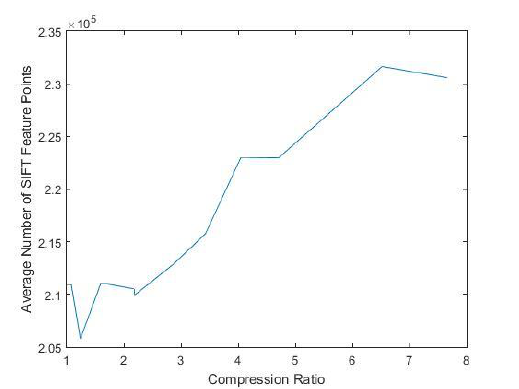
Figure 11. Average number of SIFT feature points extracted from the original and compressed image sets The average number of feature point matches of the original and compressed images is shown in Figure 12. It can be seen that the average number of feature point matches is not correlated with the compression ratio. The average number of feature point matches of the original image sets is almost the same as that of the lossless compressed image sets.